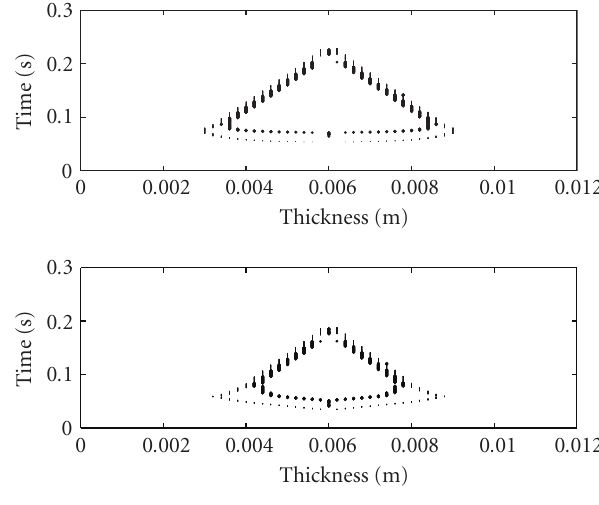
Figure 4.4. Example 1: extent of mushy and molten regions as a function of time for R g = 0 (top), R g = 10 − 9 initially (bottom). Darker markers indicate molten zone; lighter markers indicate mushy